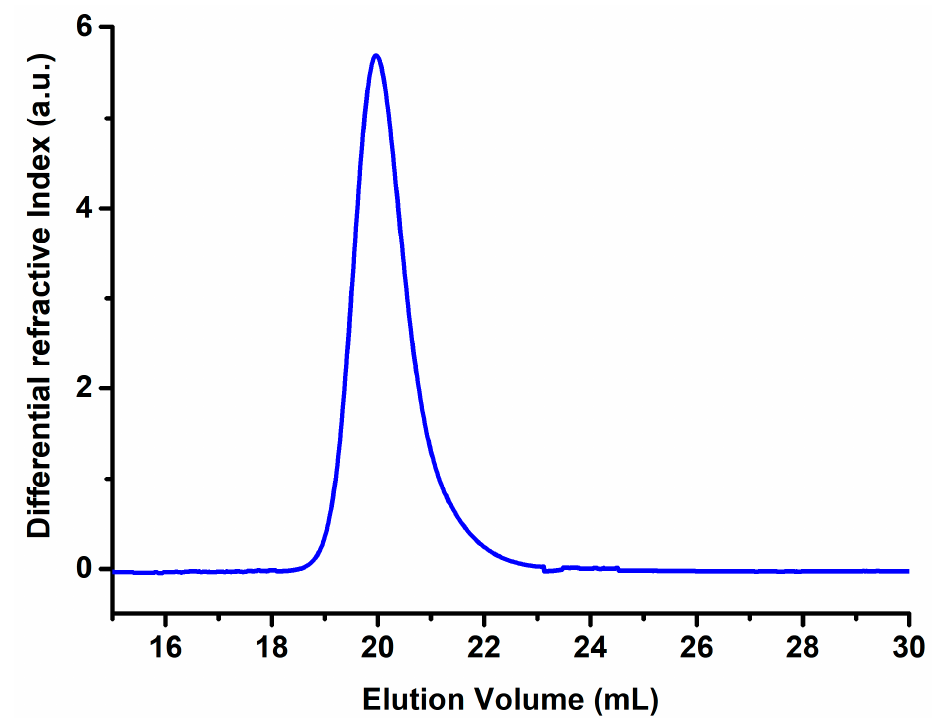
Figure 14. SEC eluogram of the final PLL 78 – b –(PLL 10 – g –PHIS 15 ) block – graft polymer in water. 3.4. Study of the Secondary Structure of PLL 78 –b–(PLL 10 –g–PHIS 15 ) Block–Graft Copolypeptide